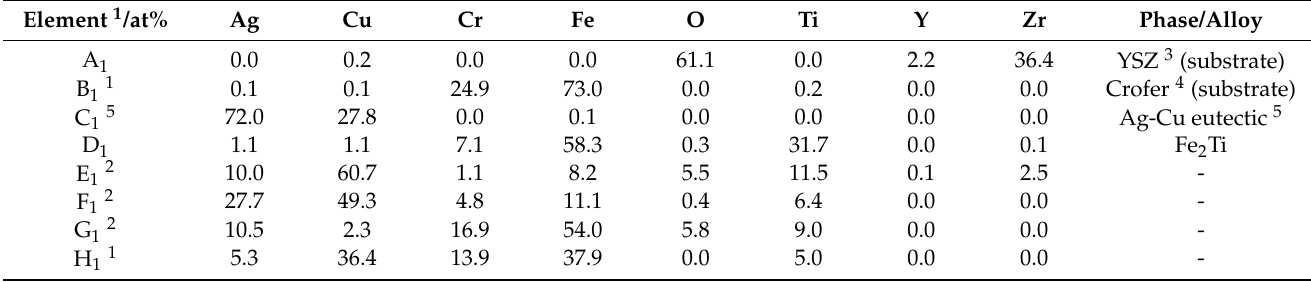
Table 2. EPMA WDS quantitative chemical analyses of BJ-1 in Figure 3b–d.